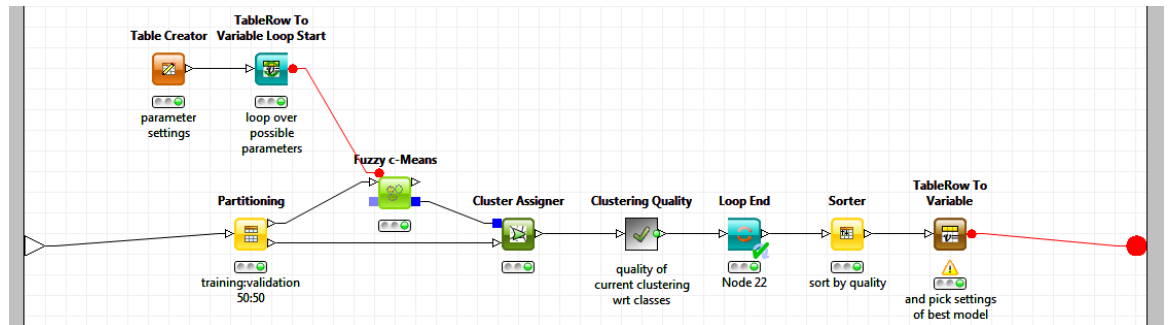
Figure 18: The subworkflow iterating over several settings of the fuzzy c-means algorithm to identify the optimal number of clusters and the value of the